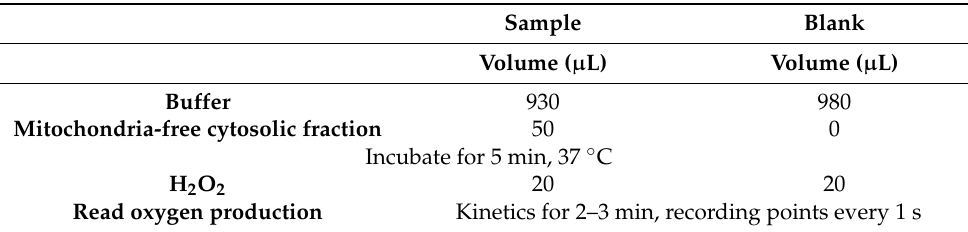
Figure 6. CAT reduces H 2 O 2 to water and O 2 , detected using a Clark-type oxygen electrode. Table 4. Conditions and flow setup for CAT activity Table 4. Conditions and flow setup for CAT activity assay.